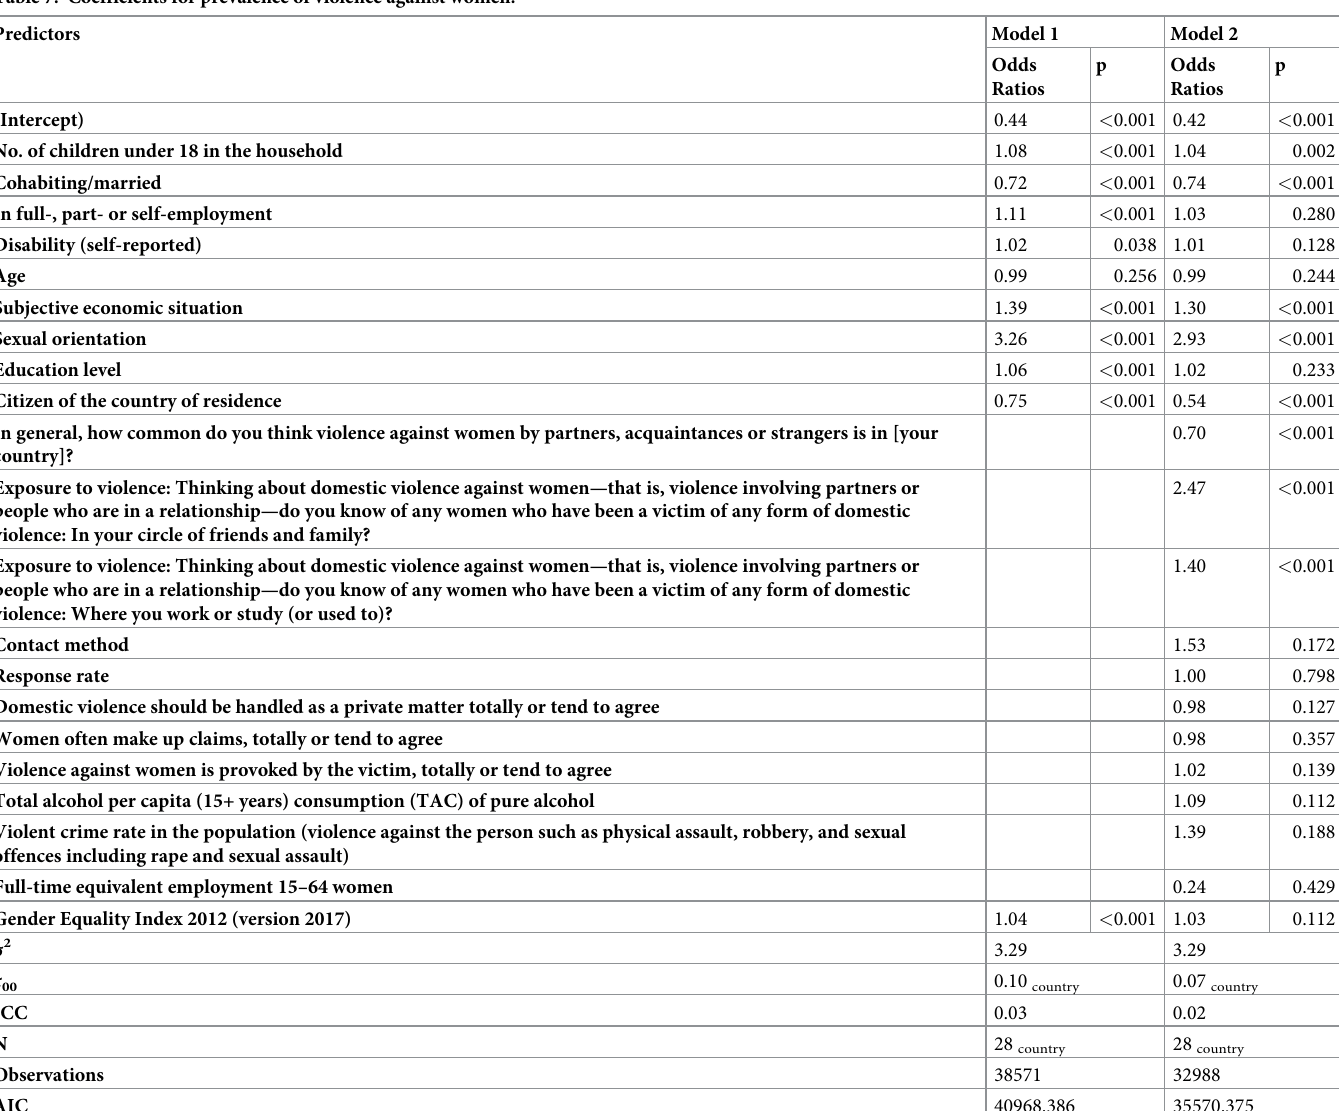
Table 7. Coefficients for prevalence of violence against